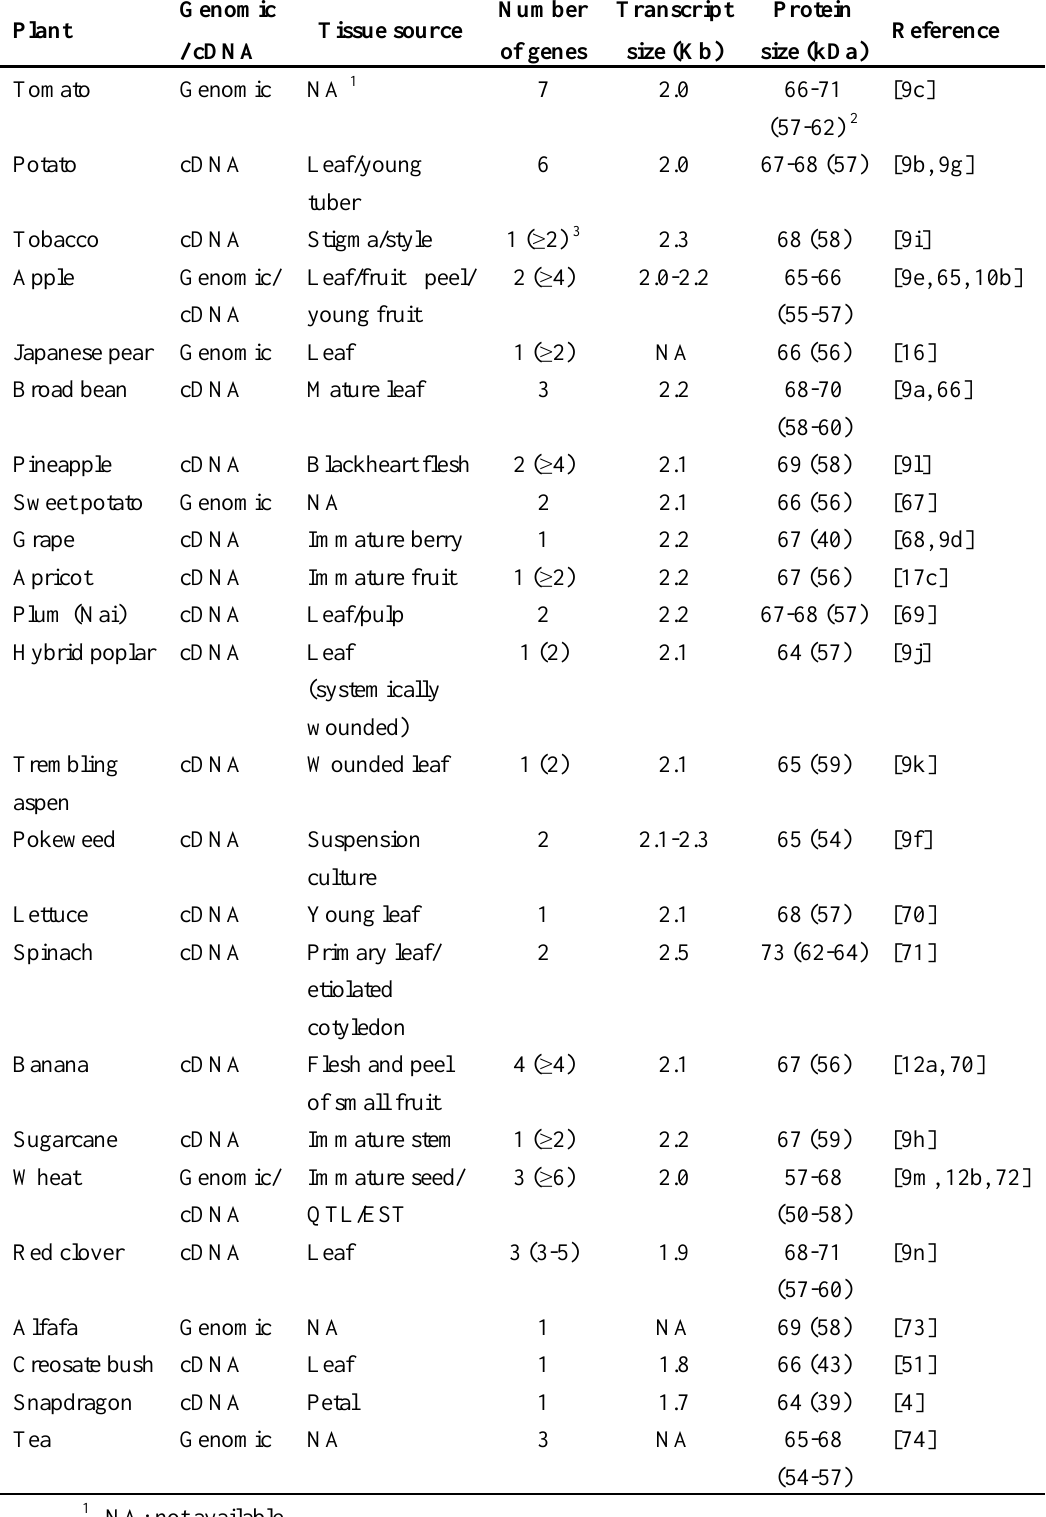
Table 1. PPO genes that have been cloned and characterized from various plant